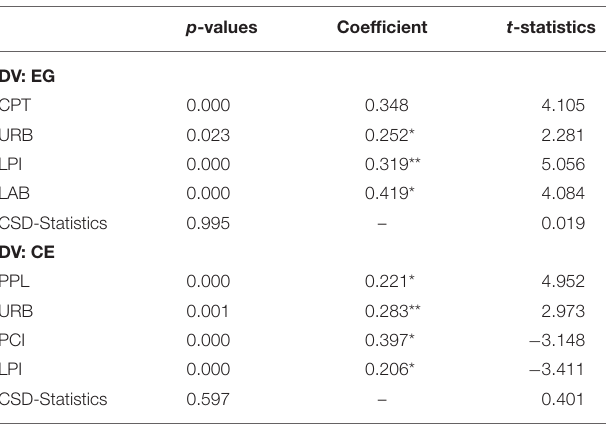
TABLE 7 | Results of CS-ARDL long run test. TABLE 8 | Results of CS-ARDL short run